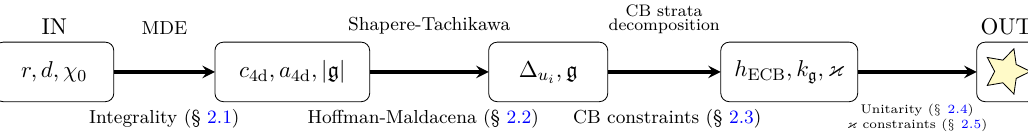
Figure 1 . A schematic depiction of our algorithm. As described in the main text, we begin by fixing the rank r and dimension d of the MDE, and then inputting the first few terms of the Fourier expansion of a candidate vacuum character χ . Various methods (given above the arrows) are then 0 used to extract increasingly refined sets of 4d data from these inputs. At each step we impose constraints (given below the arrows) on the new data, which if failed truncate the algorithm. The output of the algorithm is the data that pass all of our